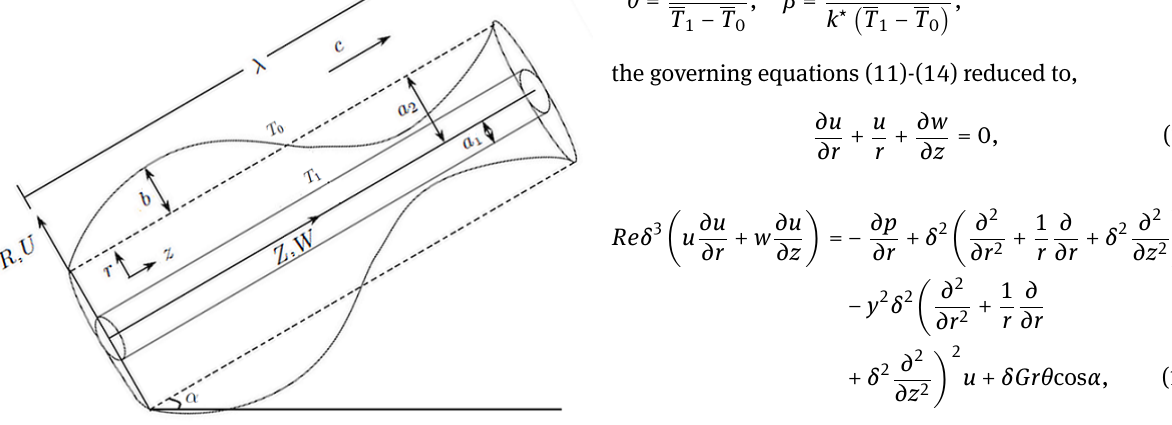
Fig. 1: Geometry of the